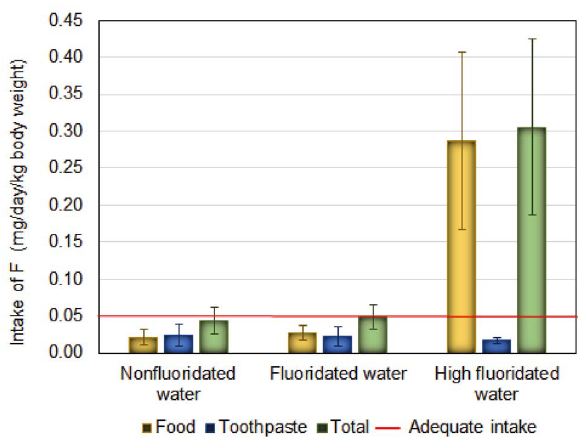
Figure 6: Estimated average total daily intake of fluoride in children from food and toothpaste in areas with nonfluoridated, fluoridated and high fluoridated water